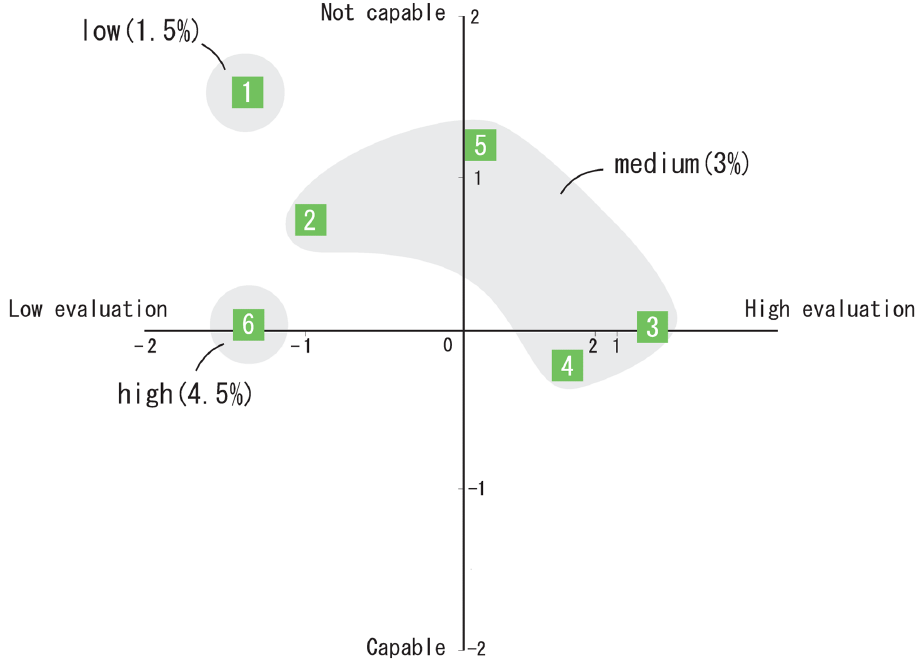
Figure 14. Scatter diagram based on the proportion levels (projection advertising signs).